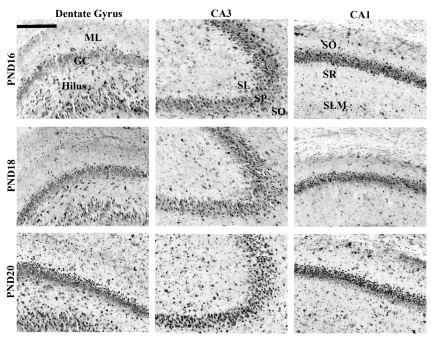
Representative c-Fos labeling in the hippocampus.Representative images for immunohistochemical localization of c-Fos in the dentate gyrus (DG), CA3 and CA1 regions. All images are from rats included in the MWM condition. Top row shows sections from PND16; middle row from PND18; bottom row from PND20. Images were taken at 10× with scale bar = 200 μm. Abbreviations: ML: molecular layer of the dentate gyrus; GC: granule cells; S:
stratum lucidum; SP:
stratum pyramidale; SO:
stratum oriens; SR:
stratum radiatum; SLM:
stratum lacunosum moleculare.